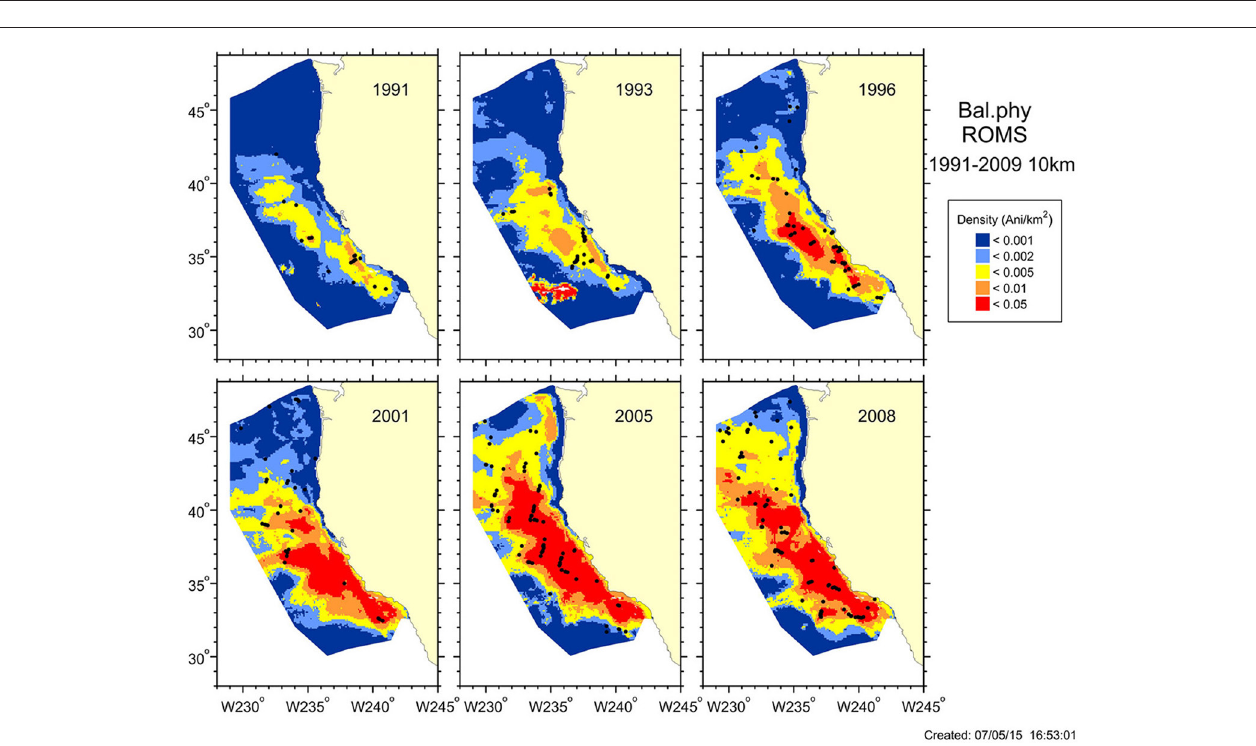
FIGURE A2 | (Case study 1) Model-based estimates of fin whale summer/fall density (animals/km –2 ) and distribution for six different years, 1991–2009, in the California Current Ecosystem. Black dots show actual sighting locations during ship surveys conducted in each year. (Details provided in Becker et al., 2016).